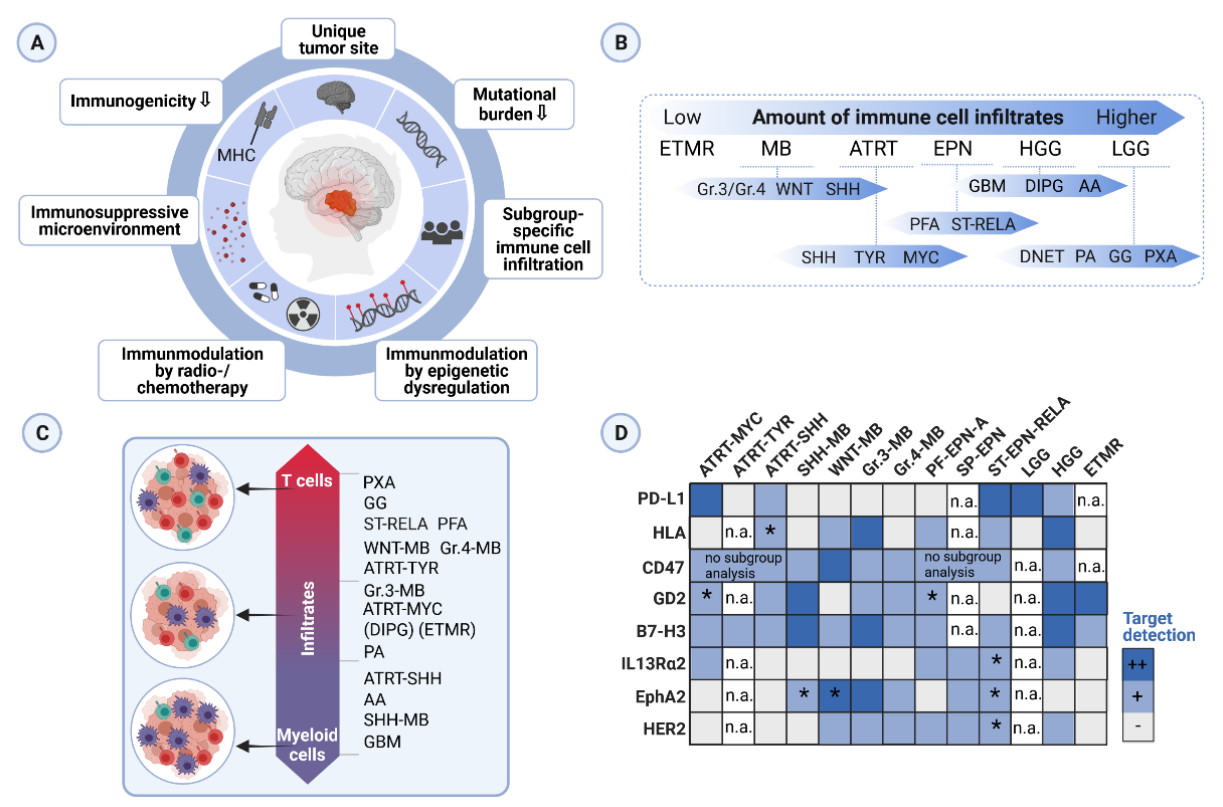
Figure 1. Graphical summary of the key topics in this review. ( A ) Hallmarks of immunogenicity of pediatric brain cancer. ( B ) Ranking of pediatric brain tumor entities according to the amount of immune cell infiltration. Subgroup ranking is related to the respective entity. Abbreviations: ETMR (embryonal tumors with multilayered rosettes), MB (medulloblastoma), ATRT (atypical teratoid rhabdoid tumor), EPN (ependymoma), HGG (high-grade glioma), LGG (low-grade glioma), GBM (glioblastoma), DIPG (diffuse intrinsic pontine glioma), AA (anaplastic astrocytoma), PFA (posterior fossa, pediatric-type), ST-RELA (supratentorial, RELA fusion), DNET (dysembryoplastic neuroepithelial tumor), PA (pilocytic astrocytoma), GG (ganglioglioma), PXA (pleomorphic xanthoastrocytoma). ( C ) Ranking pediatric brain tumor entities along a scale of two broadly defined immune cell infiltrate categories, namely myeloid-enriched (violet) or T cell-enriched (red) infiltration. ( D ) Illustration of a selection of immunotherapeutic targets evaluated in several pediatric brain tumor studies. The color code represents a qualitative evaluation. Abbreviations: PF-EPN (posterior fossa ependymoma), SP-EPN (spinal ependymoma), n. a. (not analyzed in depicted studies), * (contradicting results due to different methods used in the depicted studies). Findings in ( B – D ) were retrieved from [15–18,21,61,63,78,106,108,109,111] descriptively. Created with